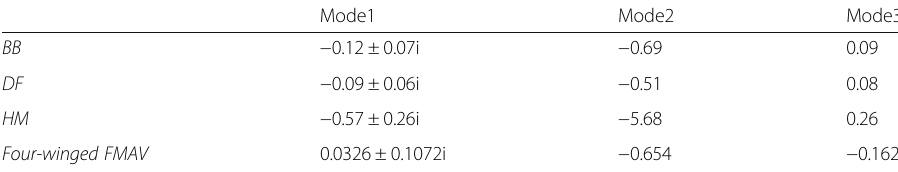
Table 11 Lateral modal comparison of four-winged FMAV and insects